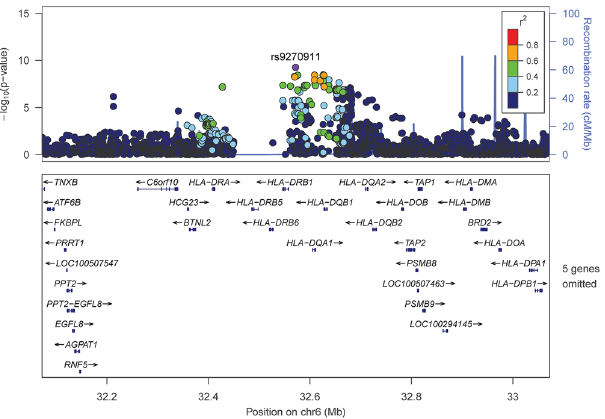
Figure 3. Association signals across a 1 Megabase region of the HLA class II region on chromosome 6 surrounding SNP rs9270911. Using LocusZoom, SNPs within 500 kb of the lead SNP rs9270911 were plotted based on their GWAS -log10 P -values, NCBI build 37 genomic position, and recombination rates calculated from the 1000 Genomes Project reference data. Each dot represents a SNP. The lead SNP rs9270911 is represented by a purple dot. The color scale of r 2 values is used to label SNPs based on their degree of linkage disequilibrium with rs9270911. Most SNPS are dark blue indicating low LD (r 2 < 0.2). The left y axis represented negative log10 P values, the right y-axis represents the recombination rate in centiMorgans (cM) per megabase (Mb). Genes found in the region are shown in relative position under the plot; arrows indicate the direction of